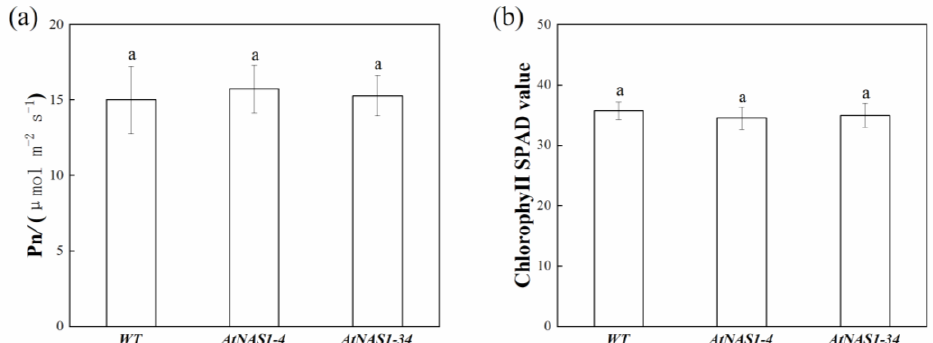
Figure 4. Analysis of ( a ) the photosynthesis rate and ( b ) the chlorophyll content in leaves of AtNAS1 -overexpression and WT potato plants. a in the picture represents significant difference. Error bars = SD. Student’s t -test was used to examine statistical significance, p < 0.05.